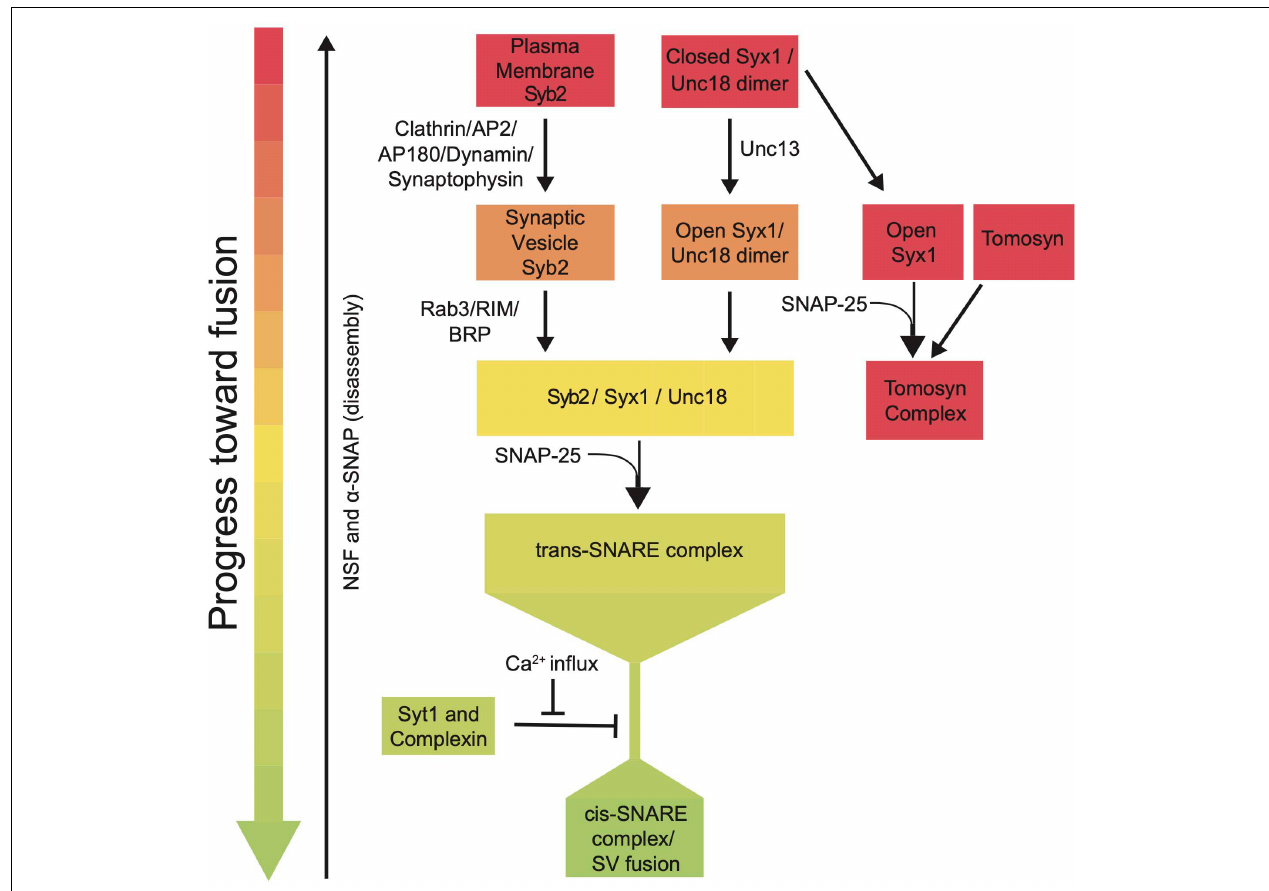
FIGURE 7 | Summary flowchart showing current models for SRP regulation of SNARE complex assembly and SV fusion.